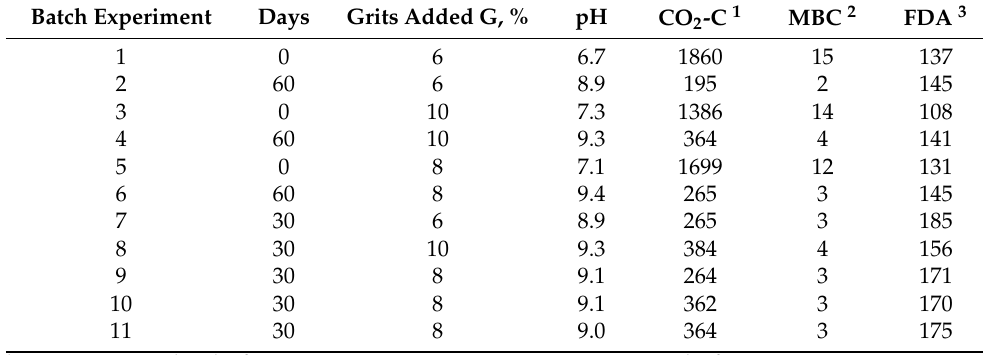
Table 2. Matrix of the face-centered composite design used to fit a second-order model. Batch